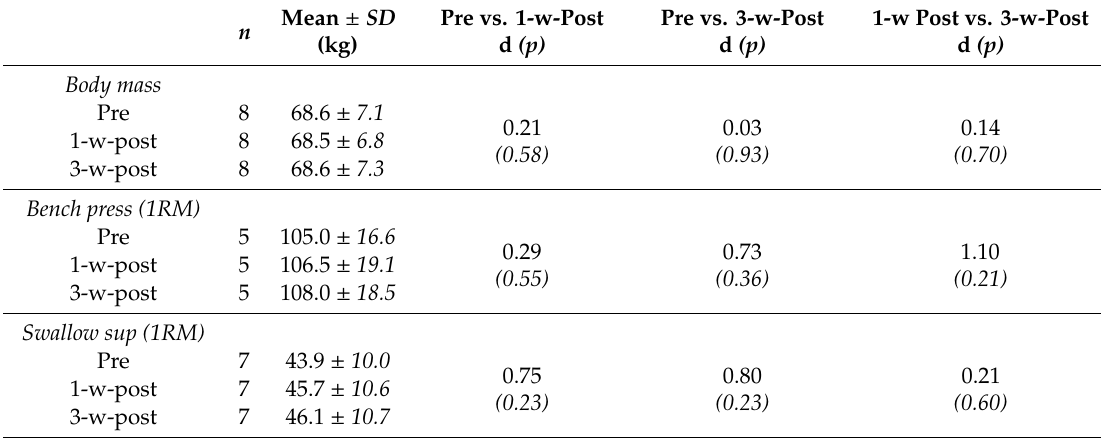
Table 2. Body mass and preconditioning exercises. Mean values ± standard deviations (SD) of the body mass and the one-repetition-maximum (1RM) for the preconditioning exercises bench press and swallow supine position (swallow sup) before (Pre) and one and three weeks after (1-w-post and 3-w-post) the 4-week eccentric–isokinetic training, as well as e ff ect sizes (Cohen’s d) and significance of changes ( p -values from t